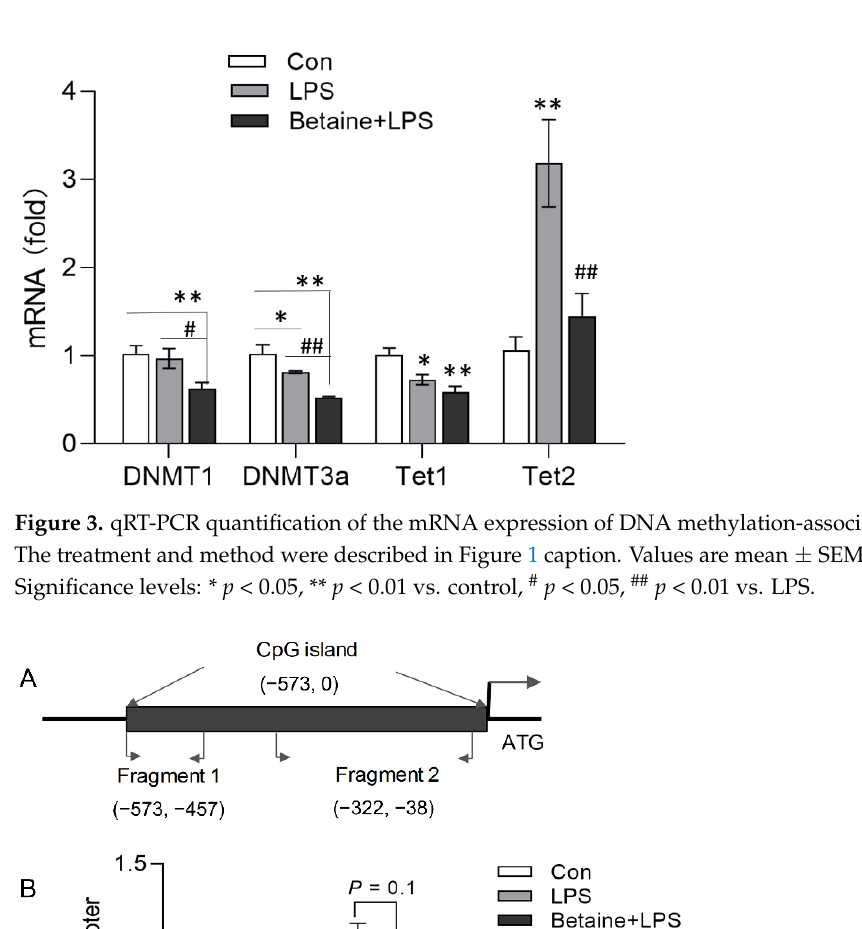
Figure 4. Schematic structure of the chicken Il-6 gene promoter and the methylation status of the CpG island. ( A ) The schematic structure of the chicken IL-6 promoter. █ shows the location of the CpG island. Fragment 1 and fragment 2 were regions detected by MeDIP-PCR. ( B ) The methylation levels of fragment 1 and fragment 2. Values are mean ± SEM, n = 4/group. Significance level: * p < 0.05 vs.